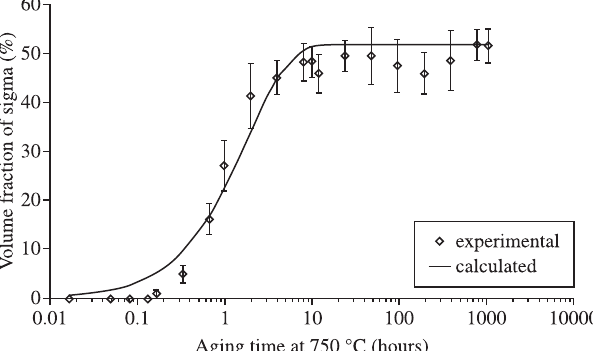
experimental calculated